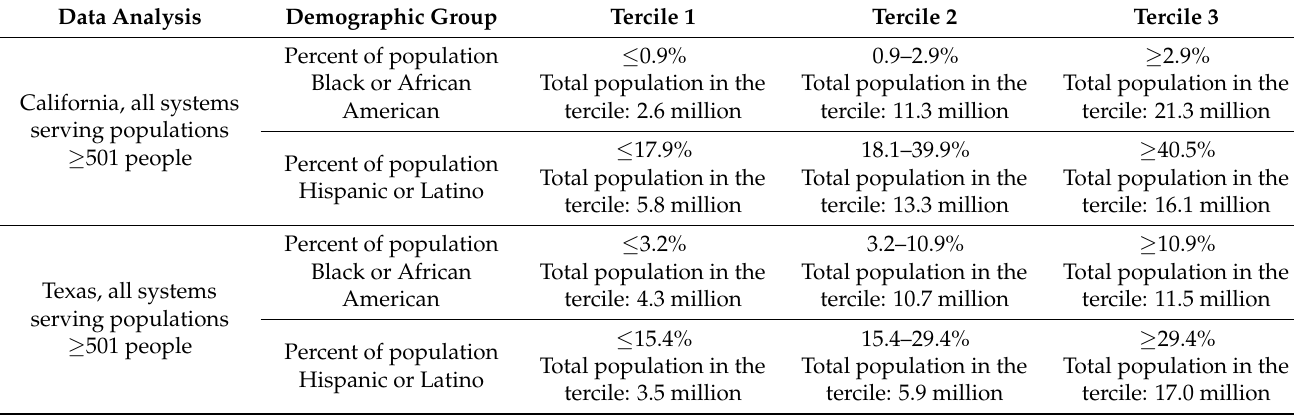
Table A3. Terciles for the cumulative cancer risk analysis and population in each tercile. With rounding, each tercile has the same number of community water systems. Due to differences in the size of population served by individual community water systems, total population differs between terciles for the same analysis. In the table, tercile boundaries are indicated with a single decimal digit and may appear to overlap due to rounding; actual tercile boundaries were defined with multiple decimal digits and do not